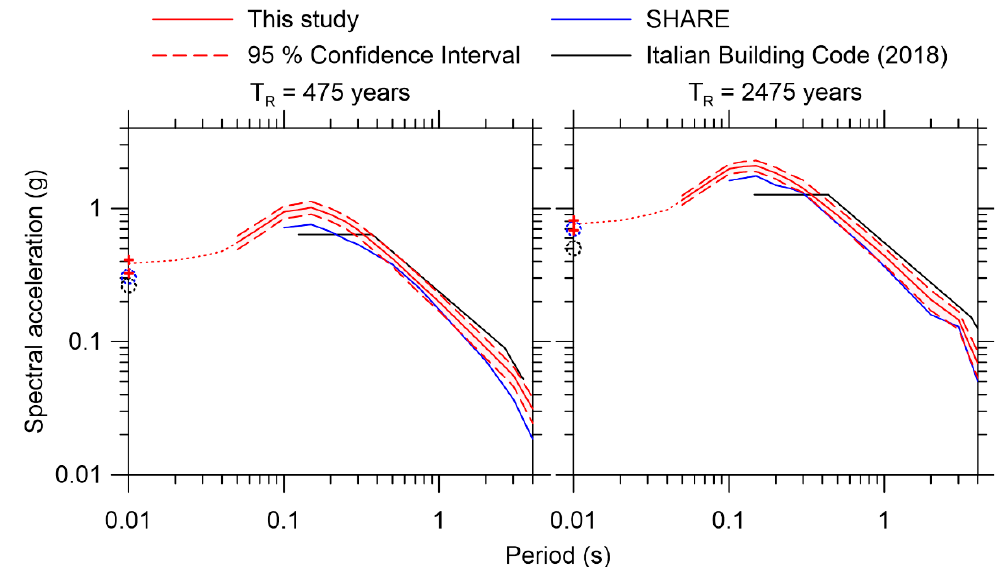
Figure 10. Site-specific, SHARE-based, and Italian Building Code (2018) UHS for the Viadotto Italia site for T R = 475 and 2475 years.